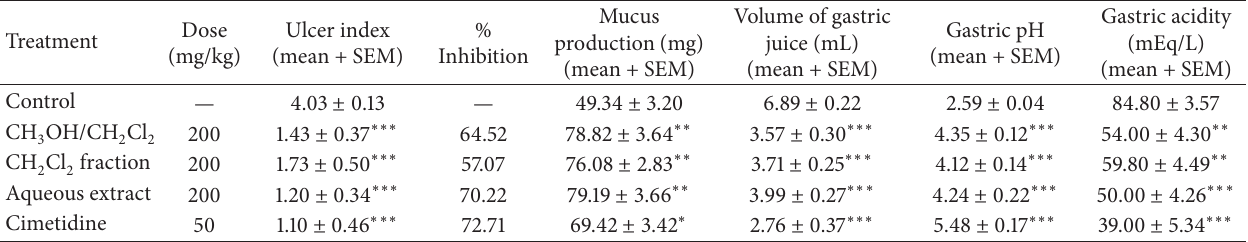
Table 4: Effects of orally administered E. speciosa on carbachol-induced gastric ulcers and gastric secretion in rats. Treatment